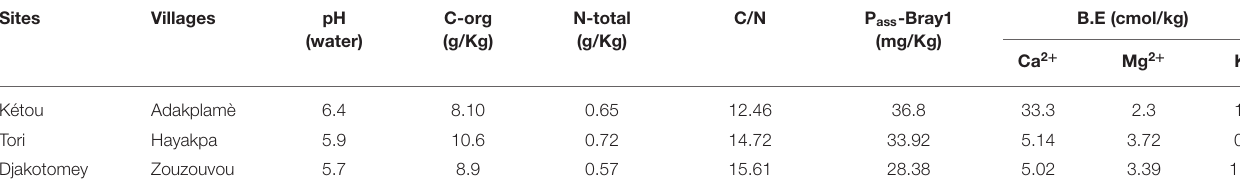
TABLE 1 | Chemical characteristics of soils in different localities. Sites